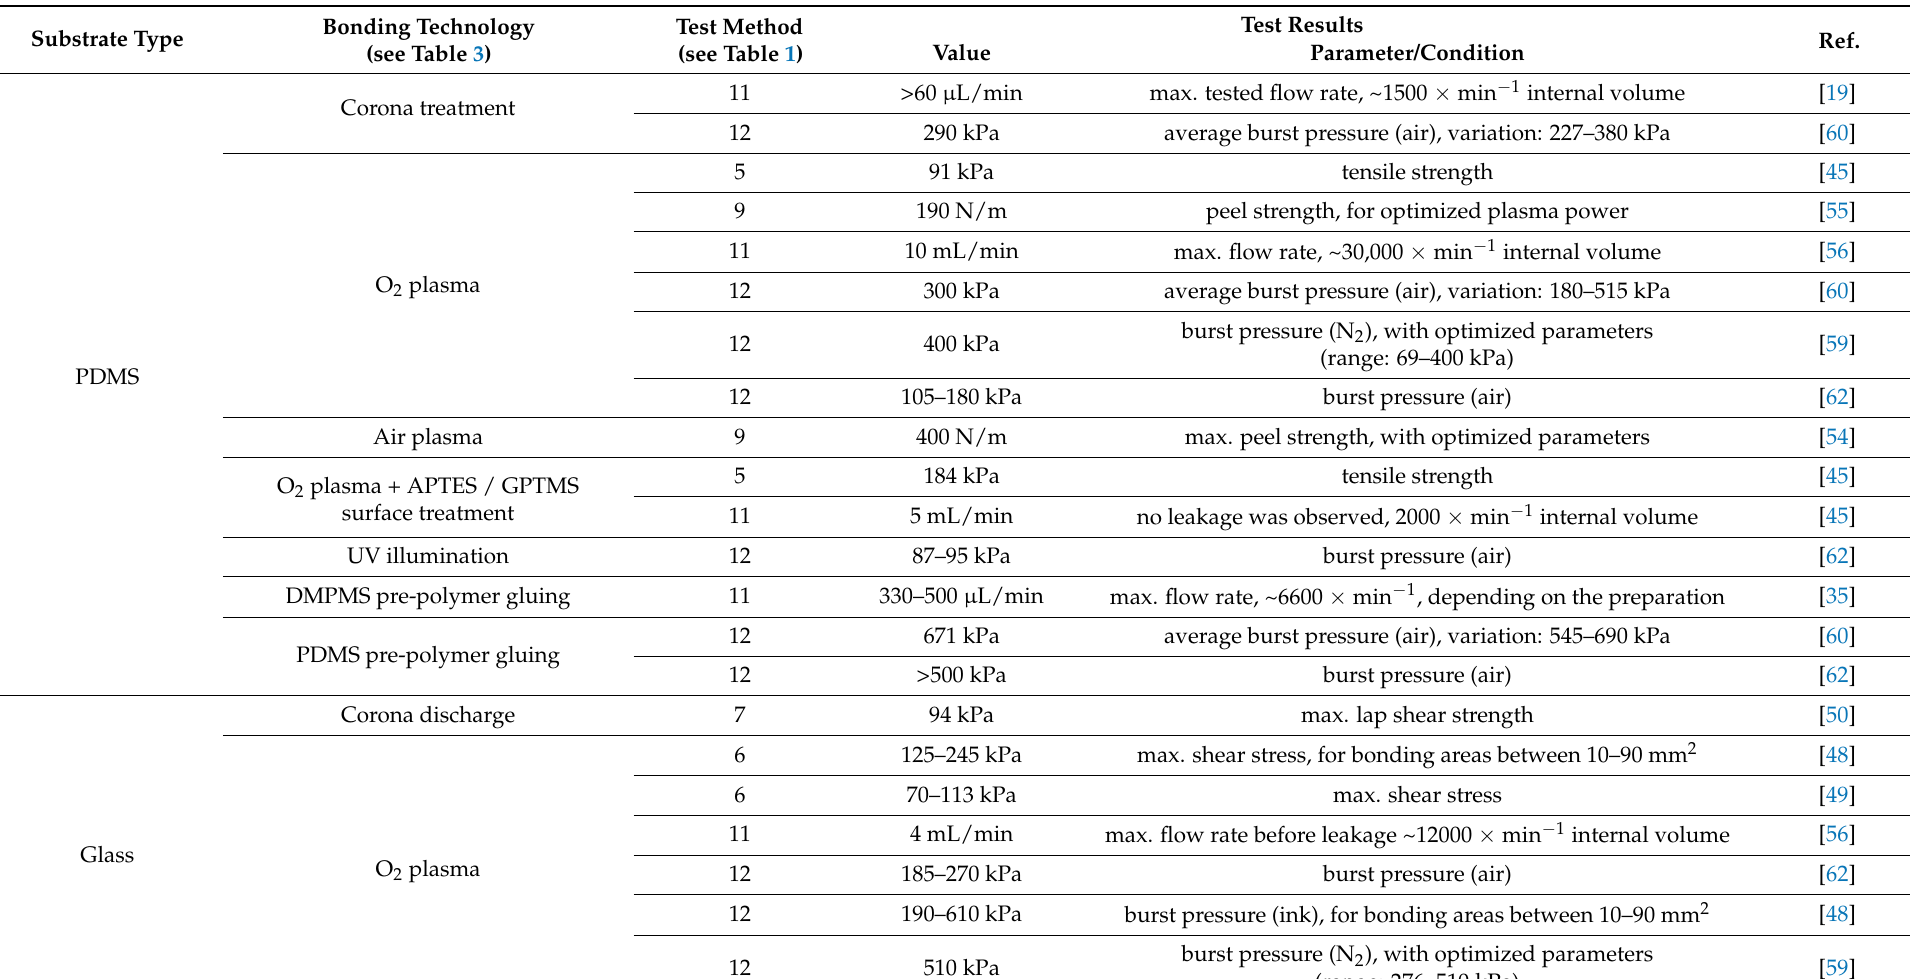
Table 2. Bond strengths measured with different test methods on PDMS–substrate bonds, categorized by the substrate type. In the table only the test results corresponding to the optimized process parameters are